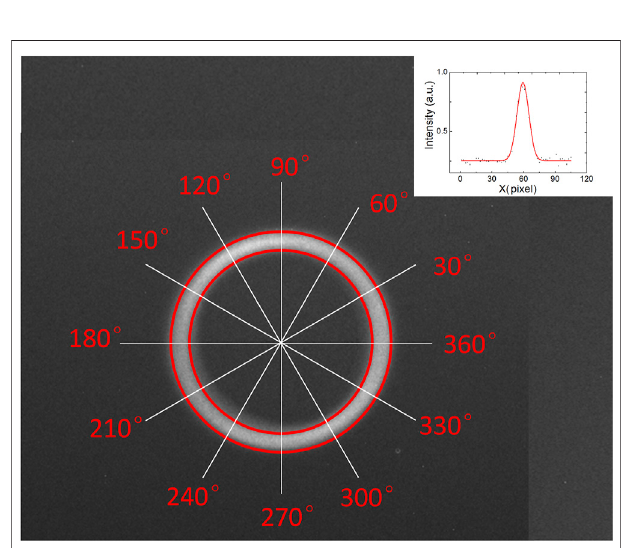
Frontiers in Physics |